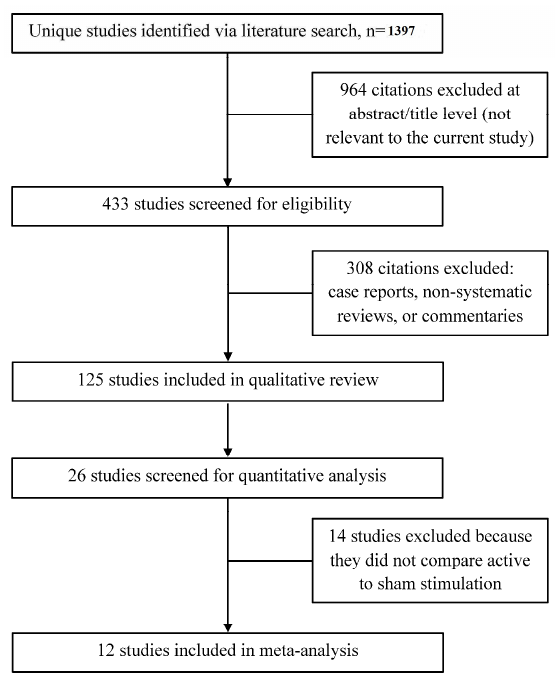
Figure 1. Flowchart of studies selected for inclusion in the qualitative review and quantitative meta-analysis.